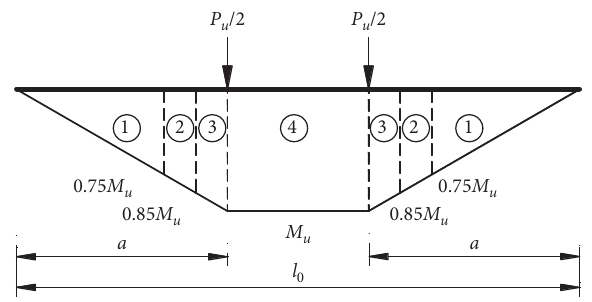
Figure 18: Bending moment diagram.